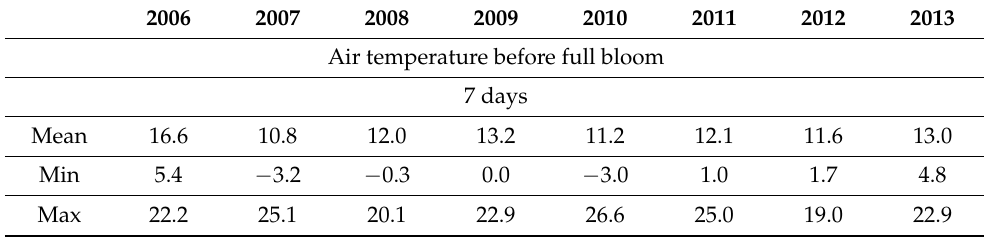
Table 1. Air temperatures in the experimental plot at bloom time in